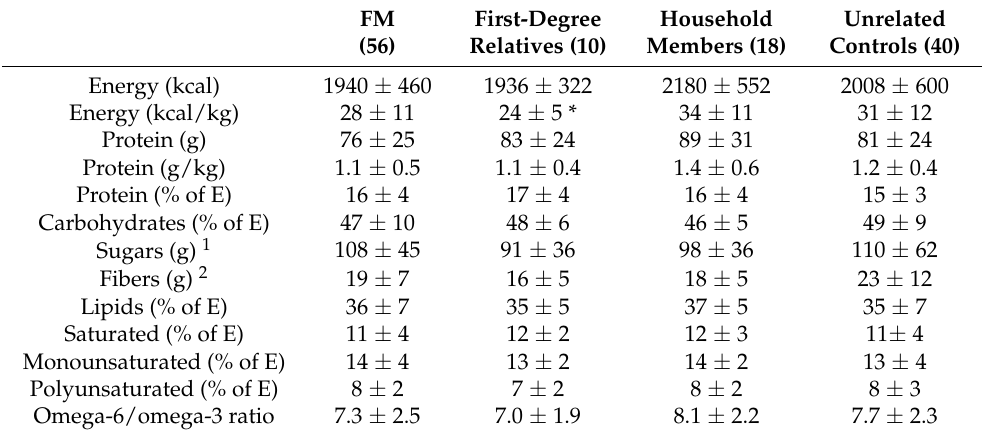
Table 2. Daily average intakes of macronutrients.